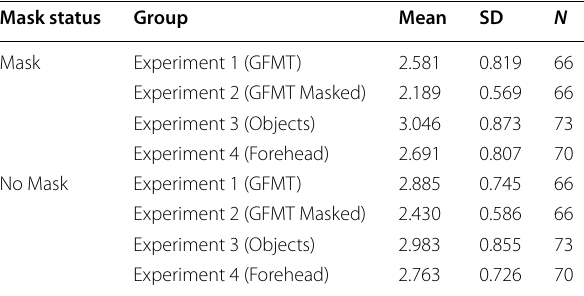
Table 2 Descriptive statistics for experiments